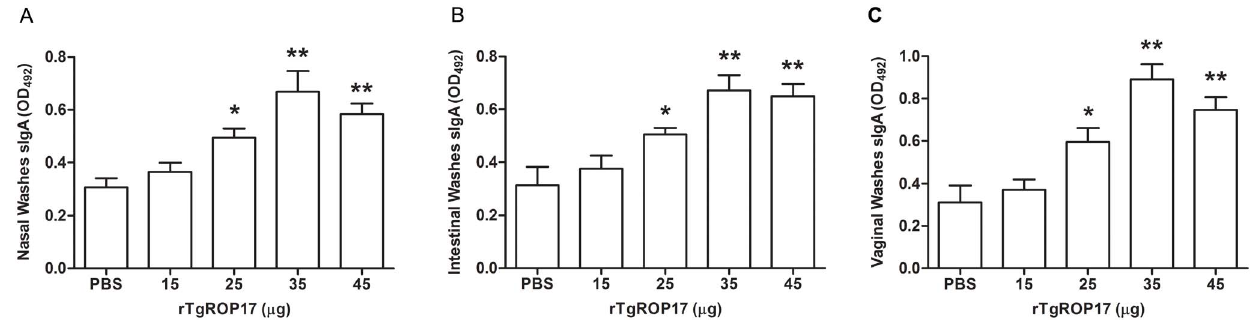
Figure 3. Nasal rTgROP17 immunization of mice induces specific SIgA antibody responses in their mucosal washes. The SIgA antibody titres in the mucosal washes of the rTgROP17-immunised mice were determined by ELISA two week after the final immunization. High levels of SIgA in (A) the nasal washes, (B) intestinal washes and (C) vaginal washes were detected in rTgROP17-immunized mice compared to those of the PBS control mice. The results are expressed as the mean value 6 SD of OD 492 (n=8) from three independent experiments. *P , 0.05, **P , 0.01